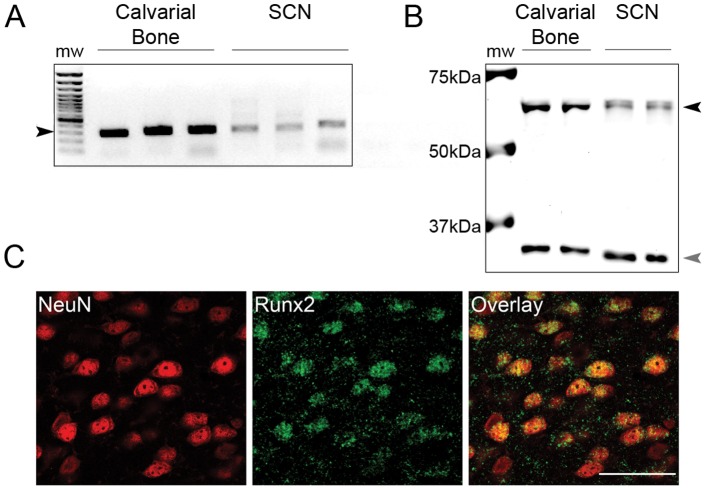
Runx2 gene and protein expression is detectable in neurons of the adult mouse brain.A) Qualitative PCR analysis of Runx2 mRNA (289 bp) expression in the suprachiasmatic nucleus (SCN) of adult mice. Lane 1: 100 bp molecular weight standard ladder (black arrowhead: 300 bp; grey arrowhead: 500 bp). Lane 2–4: Runx2 (289 bp) PCR product from reactions performed using E15 mouse calvarial bone mRNA extracts and Runx2-specific primers. Lane 5–7: Runx2 (289 bp) PCR product from reactions performed using adult mouse SCN mRNA extracts and Runx2-specific primers. Sequencing confirmed the identity of all positive PCR amplification products. B) Western blot analysis of Runx2 protein (∼60 kDa; black arrowhead) expression in the SCN of adult mice. Lane 1: Molecular weight standard ladder. Lane 2–3: protein isolated from E15 mouse calvarial bone. Lane 4–5: protein isolated from SCN of adult mice. GAPDH (∼37 kDa; grey arrowhead) protein detection served as a loading control. C) Immunolabelling of Runx2 (green) and NeuN (red) in the frontal cortex. Overlay image showing co-localization of Runx2 and NeuN (yellow). Scale bar: 50 µm.